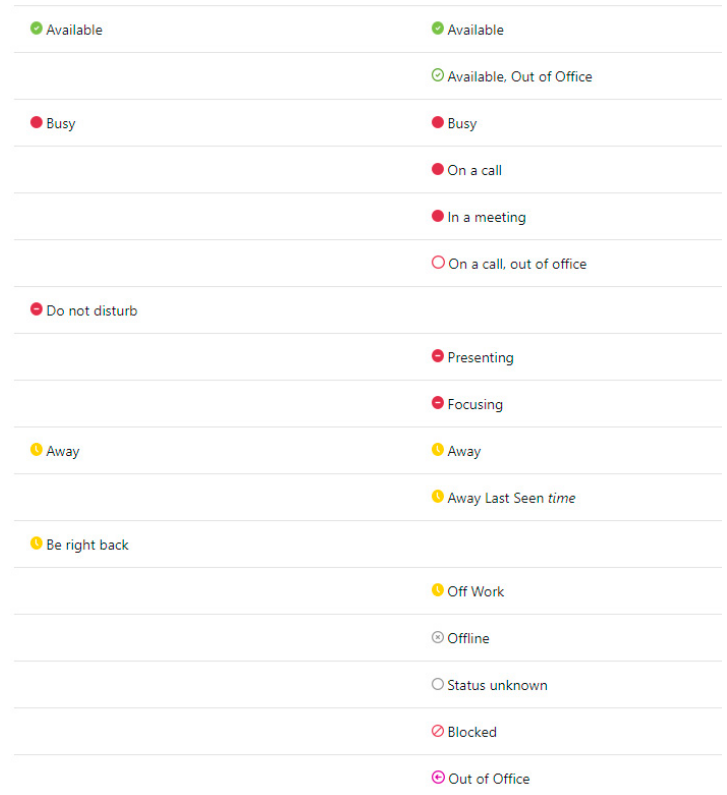
Figure 8. Availability guideline.